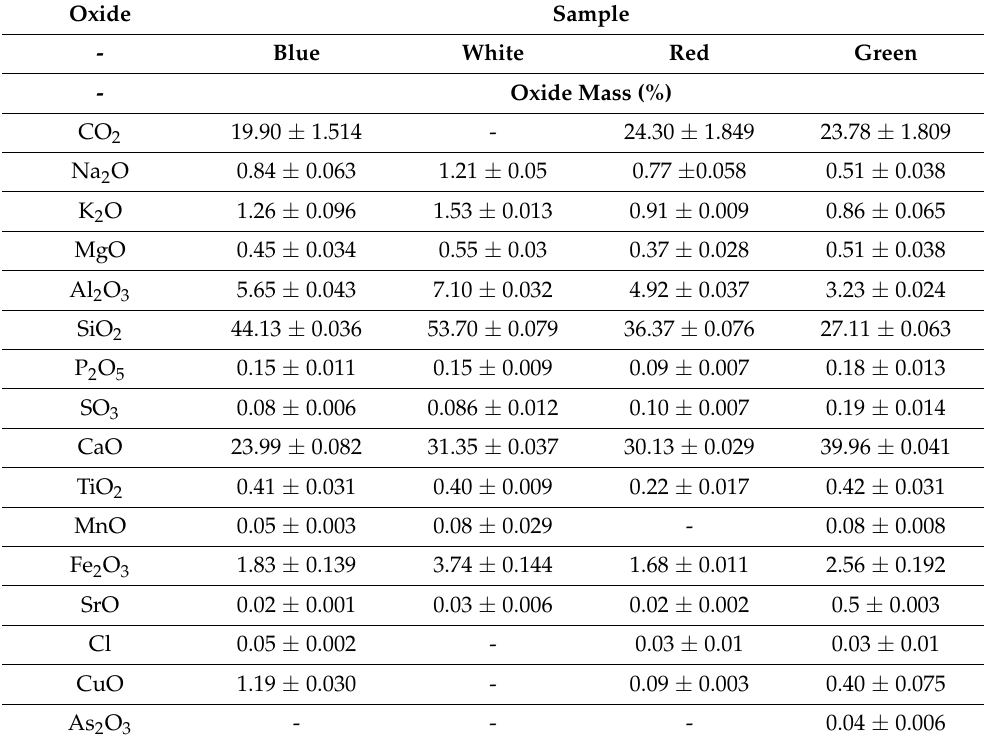
Table 1. The WDXRF results obtained from Rapoltu Mare samples. Oxide